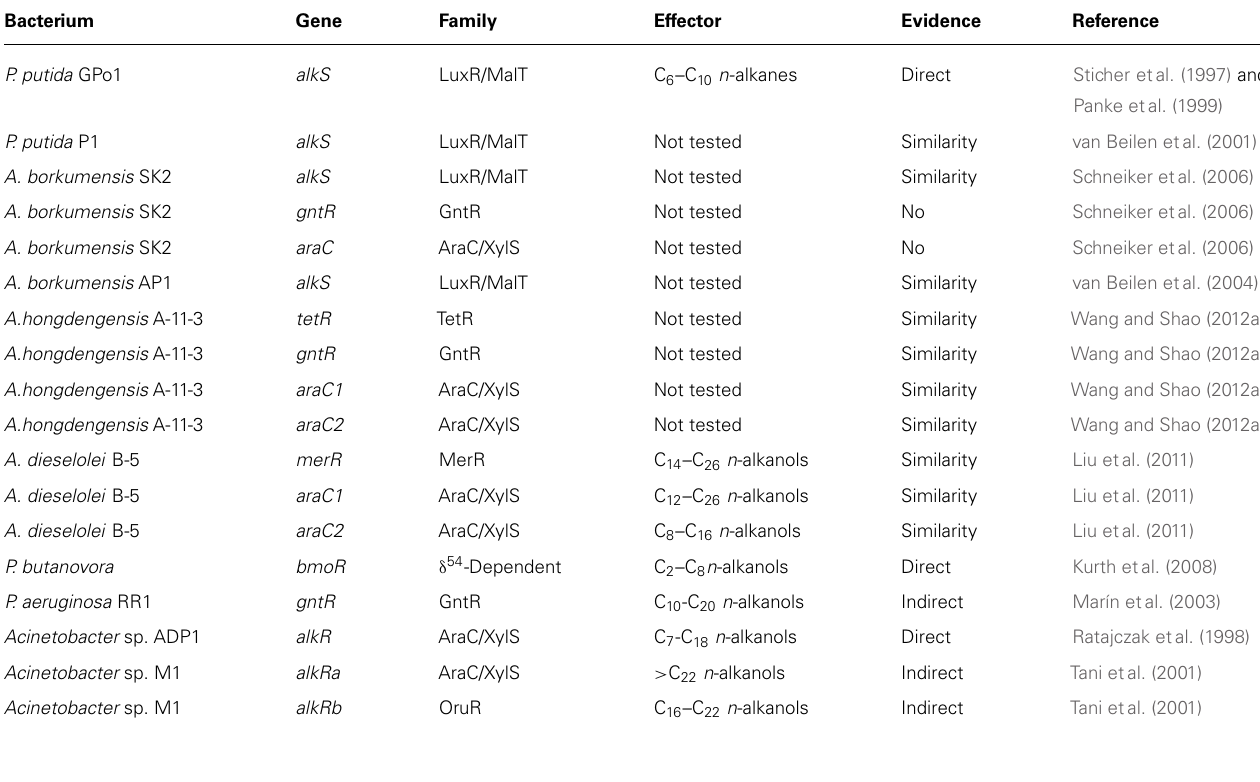
Table 1 |Transcriptional regulators known or presumed to control the expression of alkane degradation pathways.